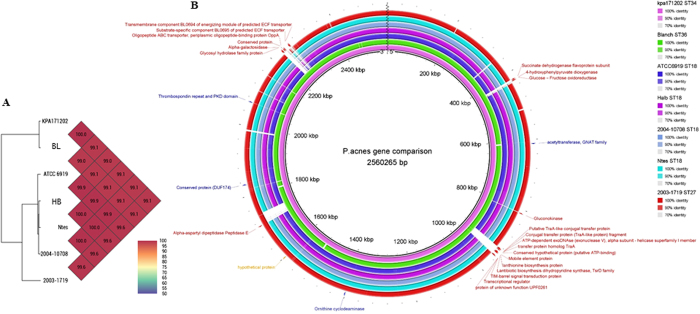
Core and pan-genome analysis of Cutibacterium acnes strains.(A) General comparison of the whole genome sequence of C. acnes generated with OrthoANI values calculated from OAT (Orthologous Average Nucleotide Identity Tool) software (http://www.ezbiocloud.net/app). (B) Comparison of C. acnes genomes. The RAST-annotated genomes of 6 C. acnes isolates (ATCC6919, HB, 2003-1719, 2004-10708, BL and Ntes) were aligned using C. acnes KPA171202 as a reference sequence. The genomes were aligned and the figure was created with BRIG software (http://brig.sourceforge.net/). Red arrows outside the outer circle indicate the locations of non-internalized strain-specific genes, blue arrows indicate the locations of internalized strain-specific genes.